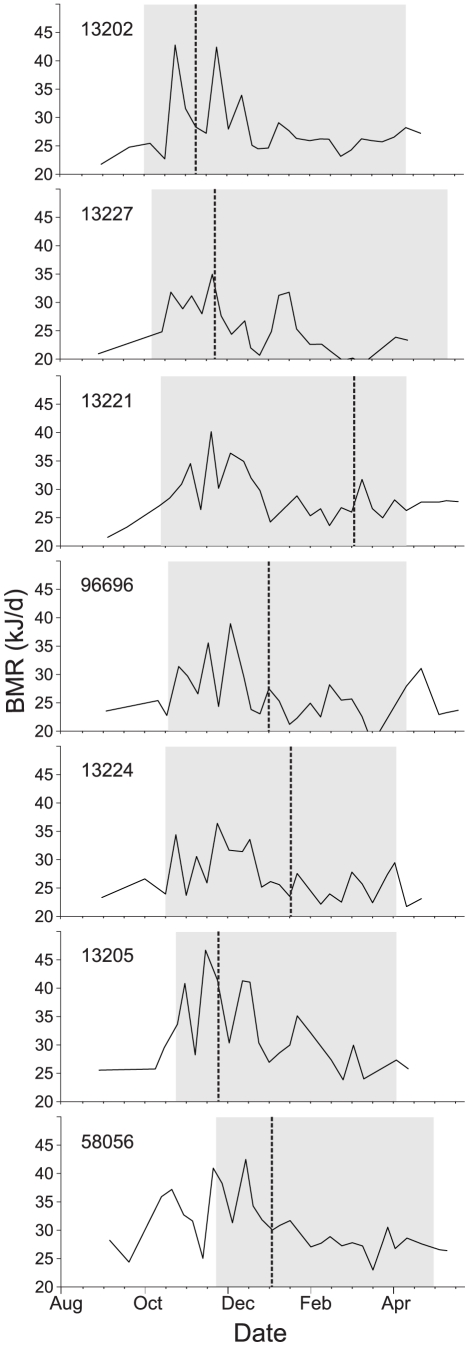
Minimum resting metabolic rate of individual White-plumed honeyeaters during molt.Minimum resting metabolic rate (RMRmin in kJ·d−1) of 7 captive White-plumed Honeyeaters preceding, during, and following the period of natural molt. Numbers indicate individual identifiers. Grey shaded areas represent a given individual's molt period, dashed vertical lines represent the individual's period of peak feather replacement.